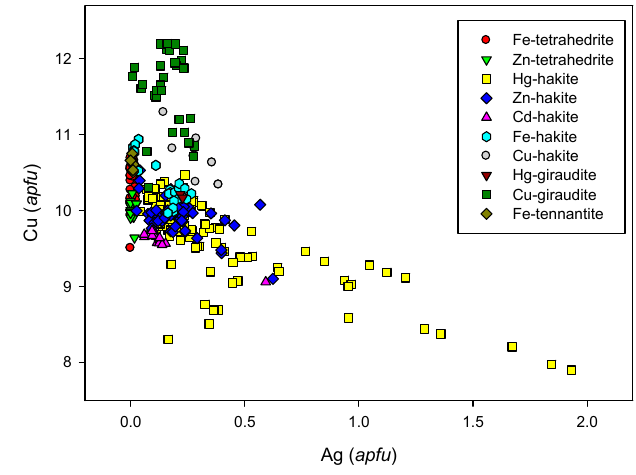
Figure 55. Homogeneous Hg-hakite (light grey) in association with uraninite (white) and Fe-tetrahedrite (dark grey). BSE photo. P ř íbram, a dump of shaft 16. Photo by J. Sejkora and P. Škácha.